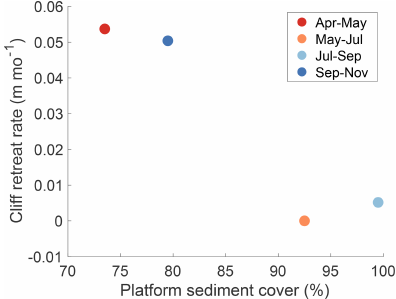
Figure 7. Platform sediment cover plotted against local cliff face retreat rate in meters per month (mmonth − 1 ) from monthly surveys conducted for the year